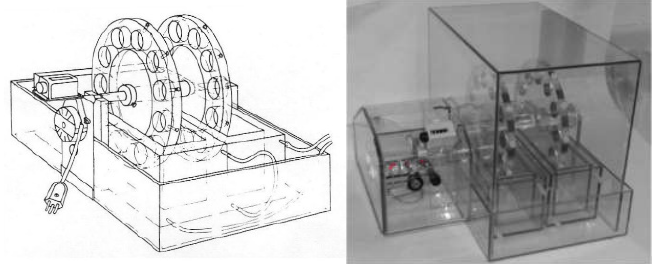
Figure 9. The Tuccillo–Nielsen system.